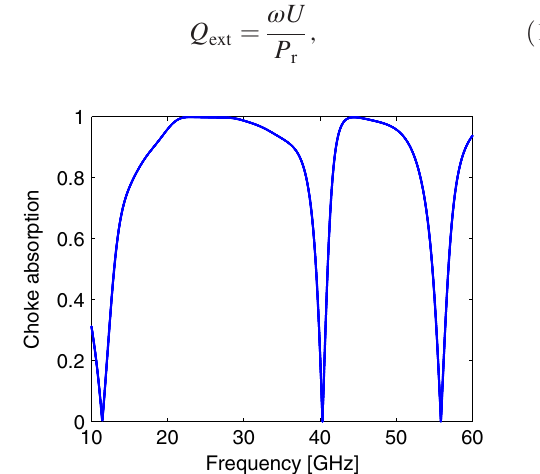
FIG. 3. Absorbing curve of THU-CHK-#1. Choke absorption is ffiffiffiffiffiffiffiffiffiffiffiffiffiffi p 1 − S 2 11